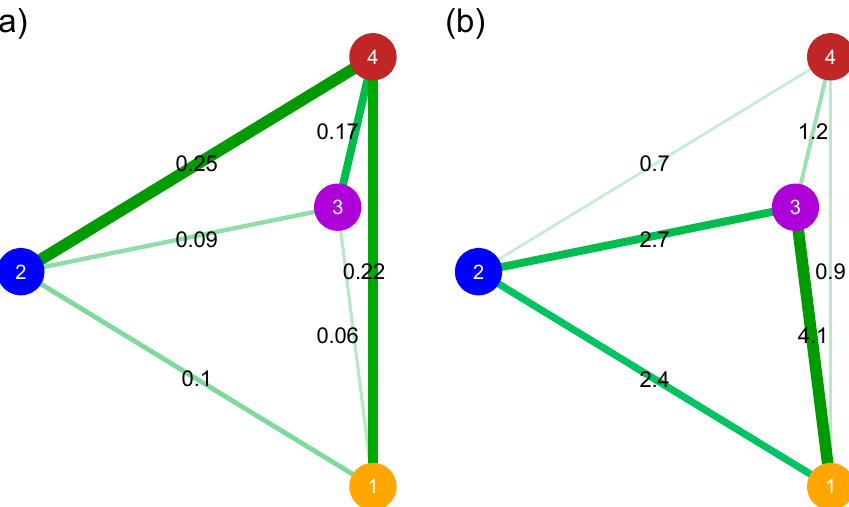
Figure 3. Networks depicting ( a ) relative divergence scores ( F ST ), and ( b ) bidirectional gene flow (computed by migrants per generation, N e m ) among four forage oat genetic clusters (circles). Clusters were determined following the unsupervised clustering approaches of the previous section: where the orange (1) and blue (2) clusters included samples of the purified genotypes AV25-S (29 lines), AV25-T (30) and some of the AV25-C samples (13); the purple cluster (3) included samples of commercial varieties, and AV25-P and AV25-Ta; and the brown cluster (4) included AV25-P samples and a single AV25-S sample.